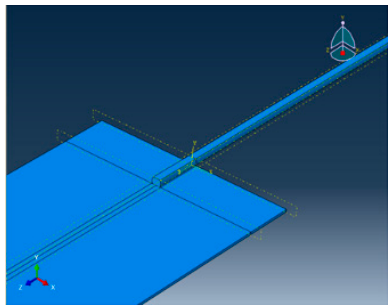
Figure 6. CAD model of the joint.